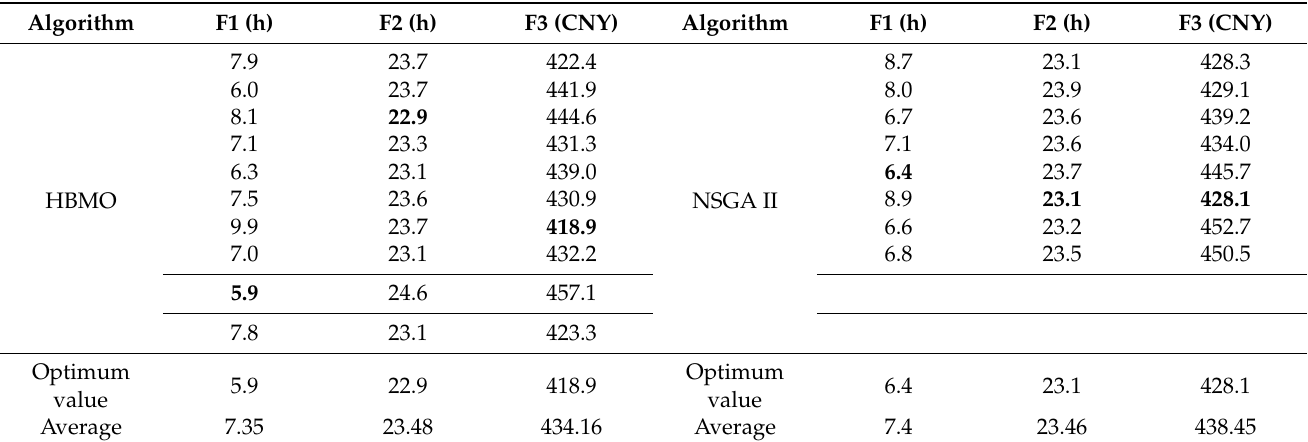
Table 7. Comparison of Pareto solutions between improved HBMO algorithm and NSGA-II algo- rithm.